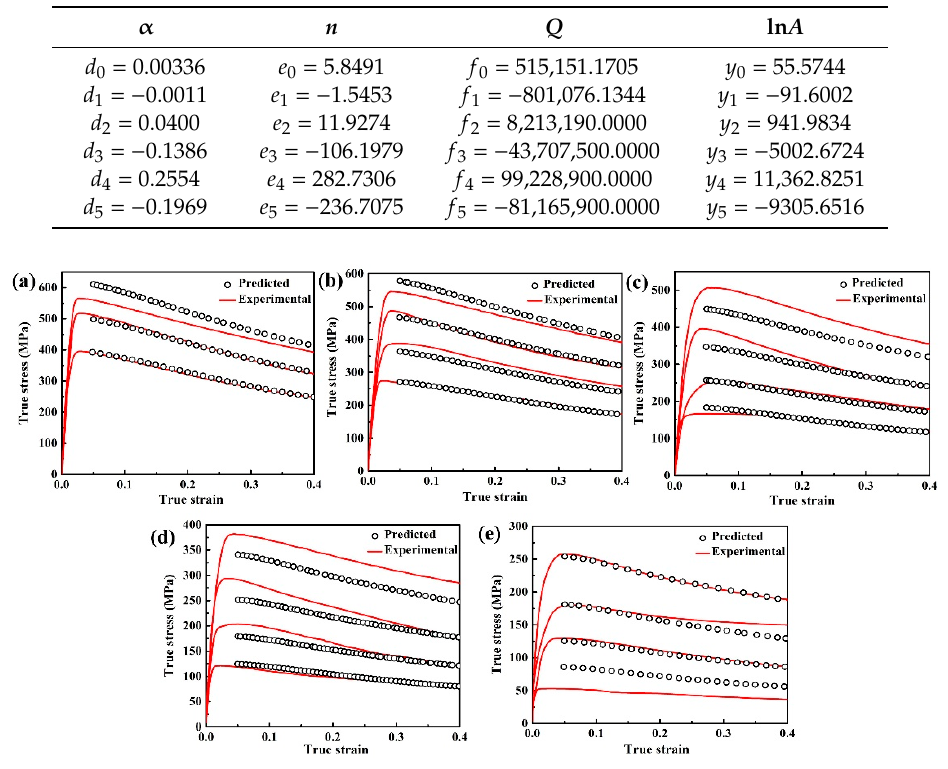
Figure 9. Comparison between the predicted stresses by the Arrhenius model and the experimental ones: ( a ) 700 °C, ( b ) 750 °C, ( c ) 800 °C, ( d ) 850 °C, and ( e ) 900 °C.